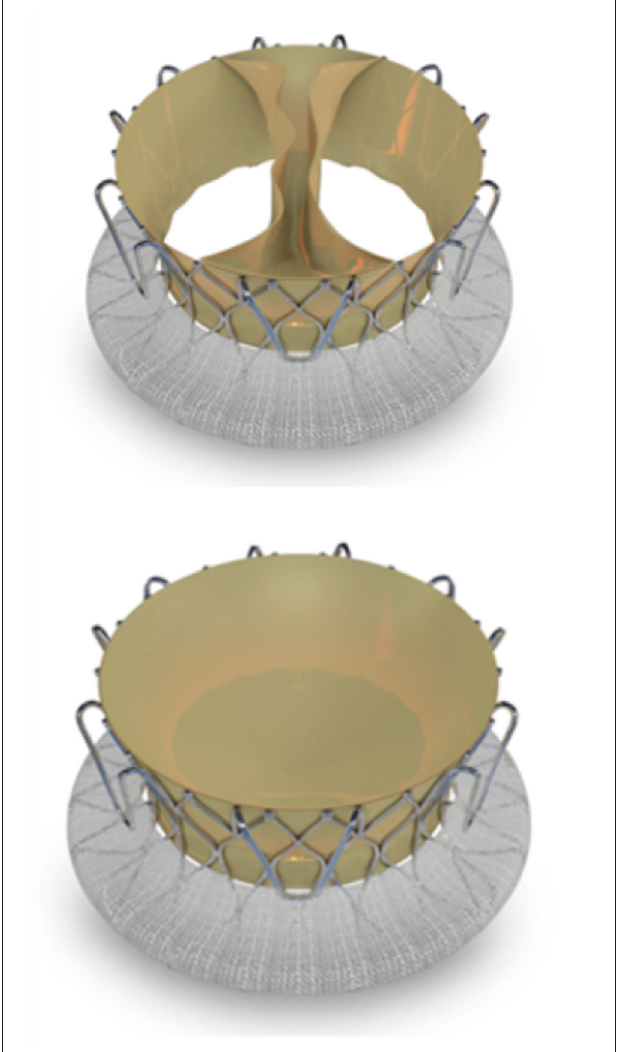
FIGURE 5 | Trisol valve. Elastic nitinol frame and an inner valve apparatus.